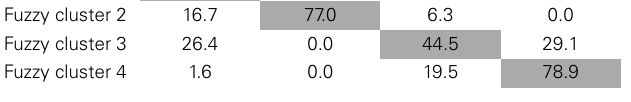
Table 2 | Means for the K-means and fuzzy clustering hard cluster solutions.